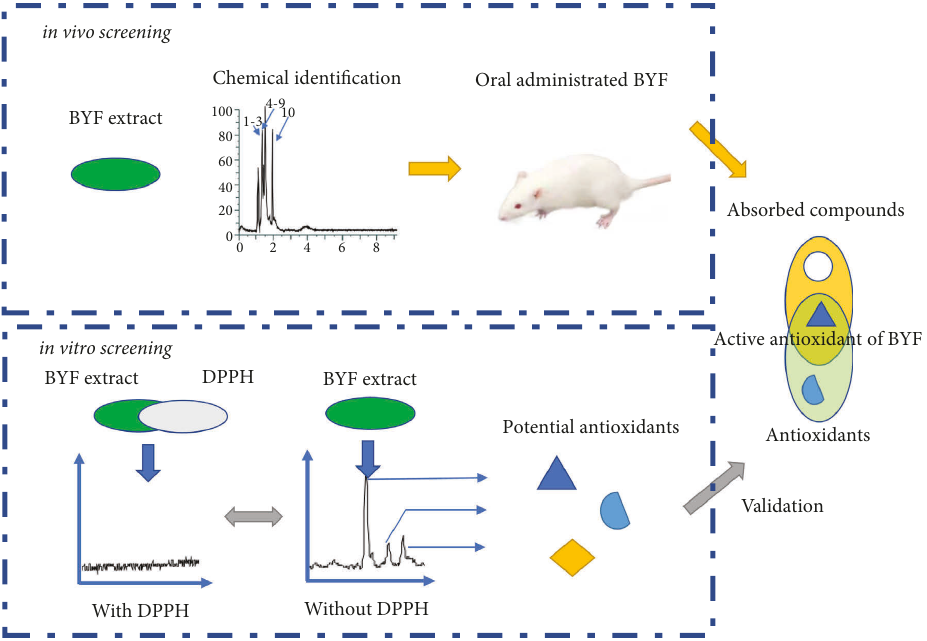
Figure 1: Schematic diagram of antioxidant screening using the offline DPPH-UHPLC-Q-extractive-Orbitrap-MS/MS